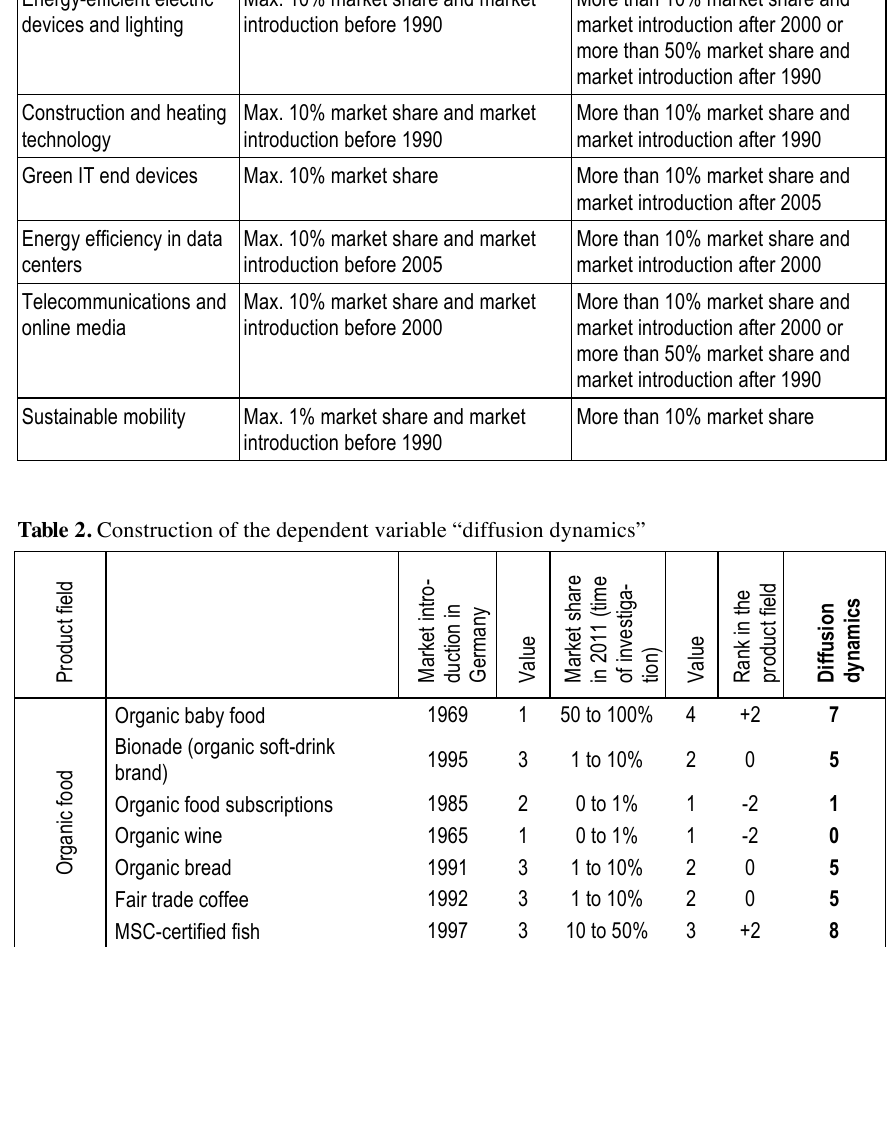
Table 1. Assessment of the rank of a specific product/service within the product field Product field Organic food